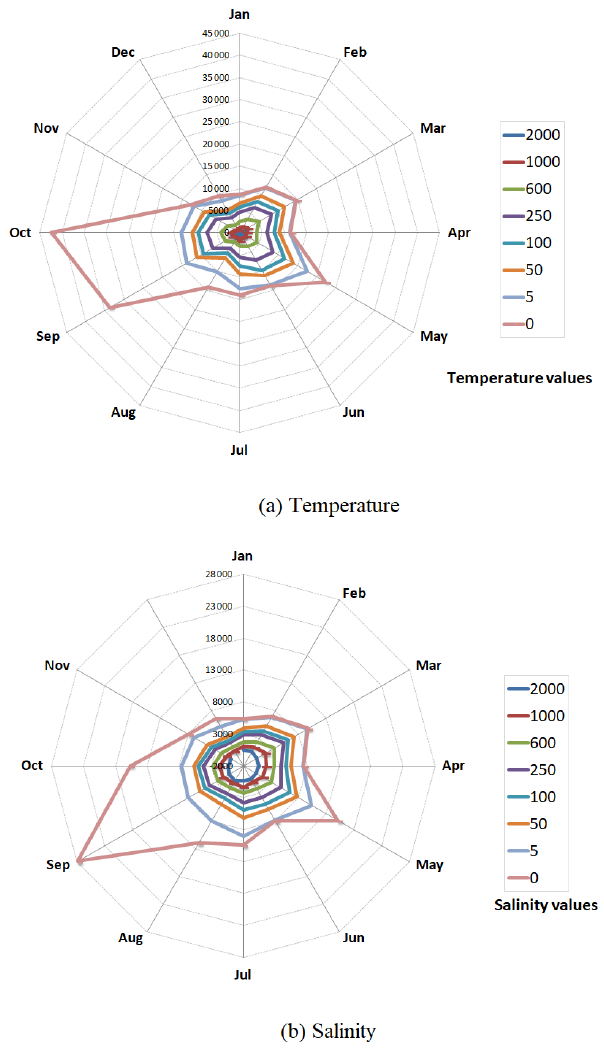
Figure 2. Number of observations per month for (a) temperature and (b)